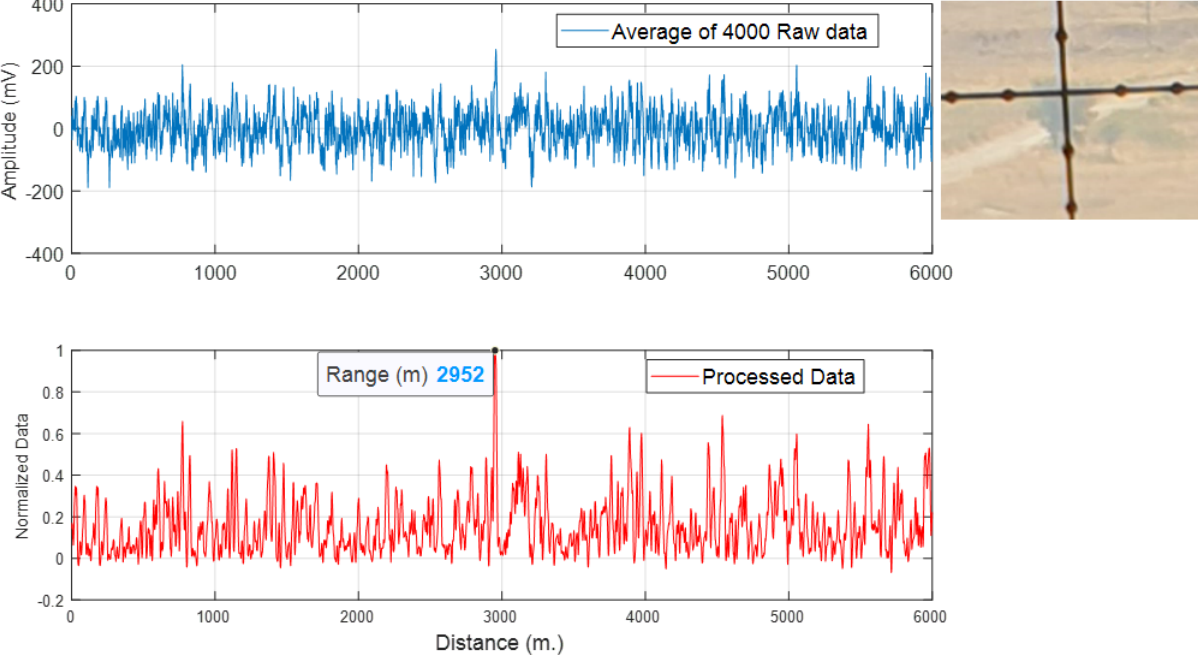
Figure 9. Average raw data ( top ) and processed data ( bottom ). The range found with our own LRF is 2952 m. The number of averaged raw data frame, N is 4000.